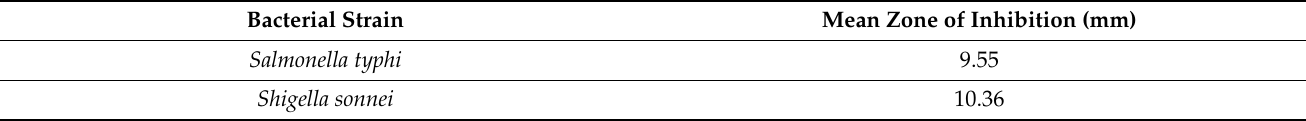
Table 3. Antibacterial activity of the CF of P. lilacinus . Bacterial